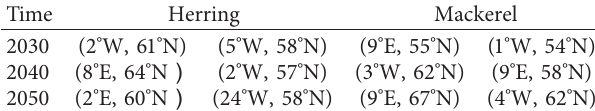
Table 1: Predicted migration positions of herring and mackerel.